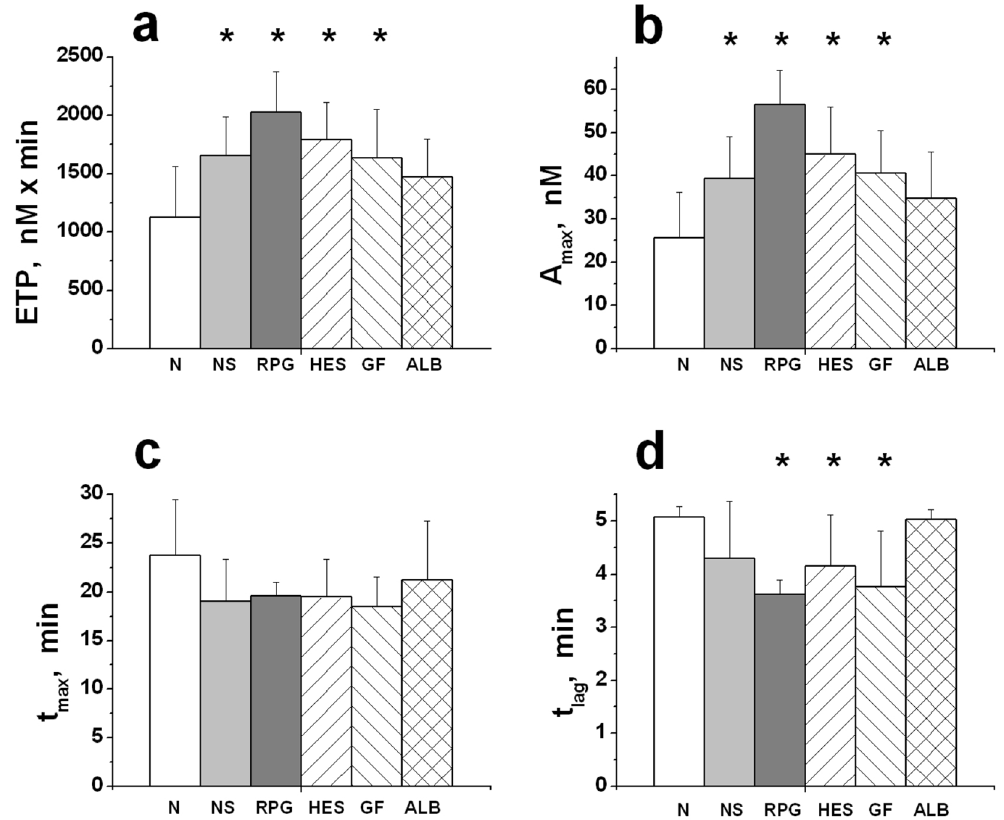
Figure 3. The parameters of TGT in undiluted plasma (N) and in plasma diluted with various PEs two-fold. ( a ) – The endogenous thrombin potential (ETP); ( b ) – the maximal concentration of thrombin in the sample (A max ); ( c ) – time to maximal thrombin concentration (t max ), and ( d ) – lag-time of thrombin generation (t lag ). The following PEs were used for dilution of plasma (see legend to Fig. 1): NS, RPG, HES, GF, and ALB. The mean values ± standard deviation are shown (n = 8). * The values are significantly different from the corresponding values in undiluted plasma (ANOVA and paired t-test of Student, P < 0.05